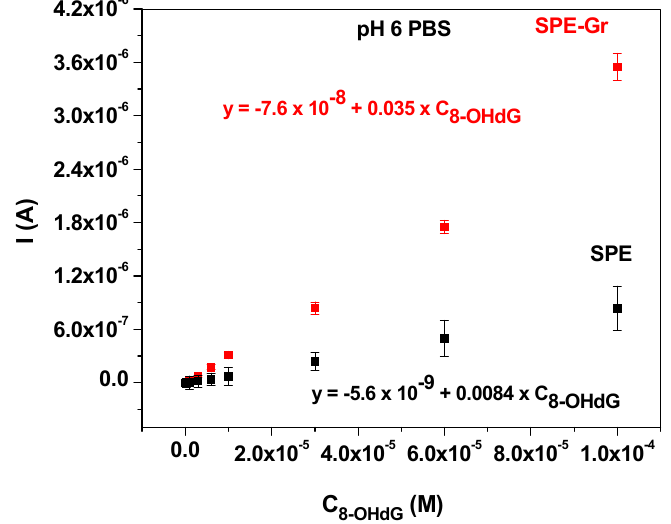
Figure 9. Calibration plot of SPE (black) and SPE-Gr (red) obtained in pH 6 PBS solutions containing various concentrations of 8-OHdG.